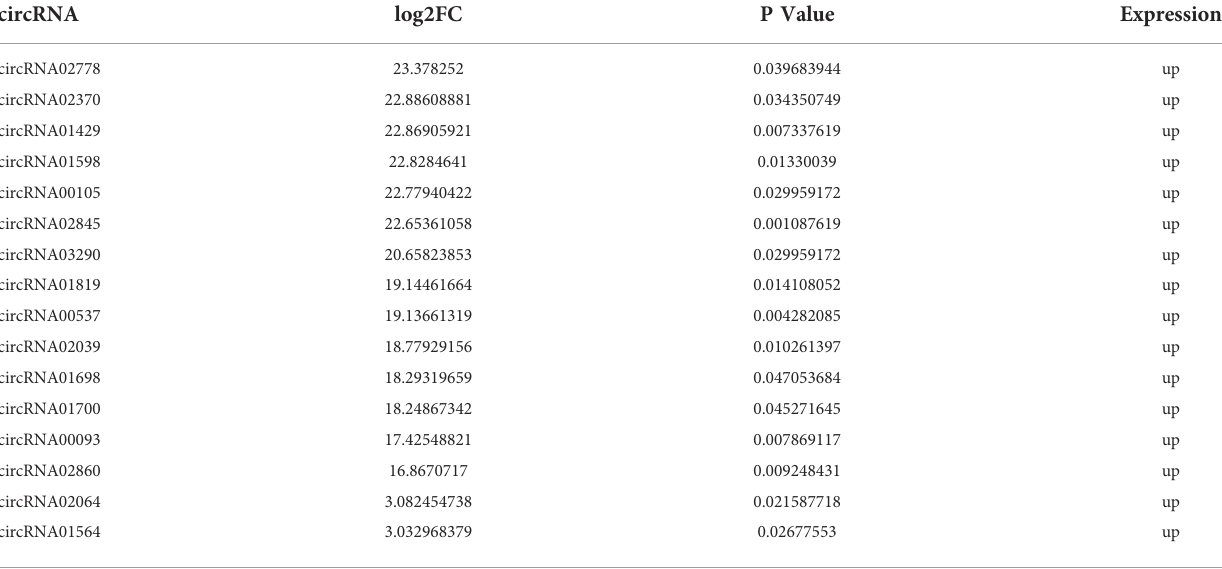
TABLE 1 The expression pro fi le of DEC sin SCI tissue sin